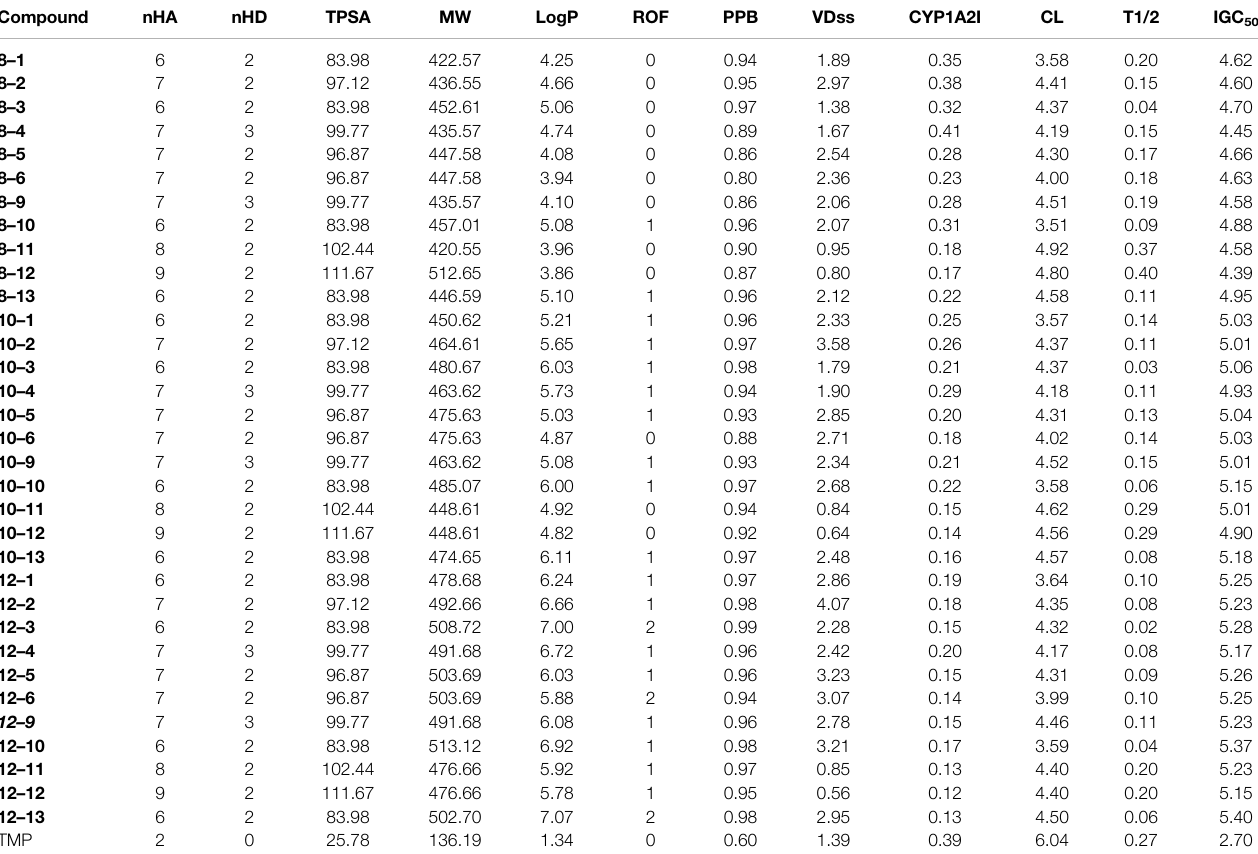
TABLE 2 | Drug-like properties of 33 TMPH compounds.